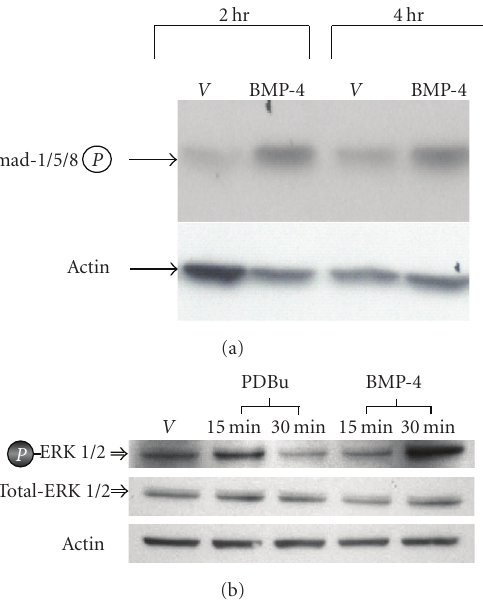
Figure 2: BMP-4 activates Smad 1/5/8 and MAPK/ERK in cultured melanocytes . (a) Paired cultures of melanocytes were treated with vehicle or BMP-4 (25ng/mL) for 2 and 4 hours. At each time point, cells were harvested and immunoblot analysis using polyclonal antibody against phosphorylated Smad 1/5/8 was performed. As the loading control, the membrane was immunoblotted for actin. One representative result from three separate experiments is shown. (b) Paired cultures of melanocytes were treated with vehicle or BMP-4 (25ng/mL) for 15 and 30 minutes. At each time point, cells were harvested and immunoblot analysis using polyclonal antibody against phosphorylated and nonphosphorylated ERK was performed; PDBu at 1 × 10 − 6 M was used as a control. As the loading control, the membrane was immunoblotted for actin. One representative result from three separate experiments is